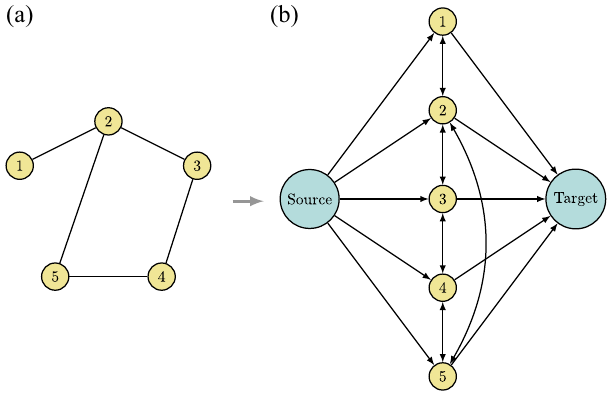
FIG. 8. Mapping the Wasserstein distance defined based on topology to a minimum cost flow problem. (a) Topology G ð V; E Þ with five vertices and five edges, from which the Wasserstein distance is defined. (b) Directed graph of the minimum cost flow problem, which is constructed using the given topology G . The minimum cost of the flow problem is equal to the Wasserstein